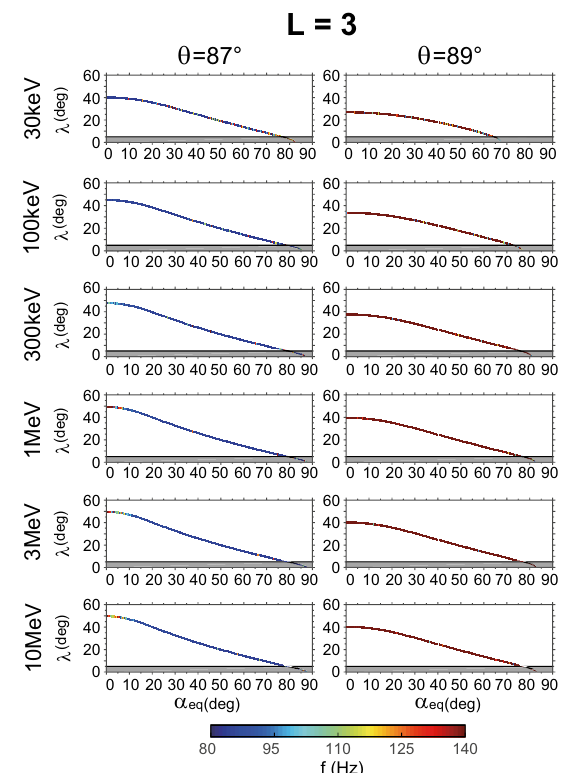
Fig. 2 Regions of resonance in (equatorial pitch angle α eq , magnetic latitude (cid:31) ) space for the Landau resonance between magnetosonic waves and radiation belt electrons at L 3 (inside the plasmasphere) = for six indicated kinetic energies (from top to bottom: 30 keV, 100 keV, 300 keV, 1 MeV, 3 MeV, and 10 MeV) and for two specific wave normal angles (from left to right θ = 87 ◦ and θ = 89 ◦ ). The wave frequency band is adopted as 0.0026 < ω/(Ω ce ) eq < 0.0044, corresponding to a frequency range of 83–141